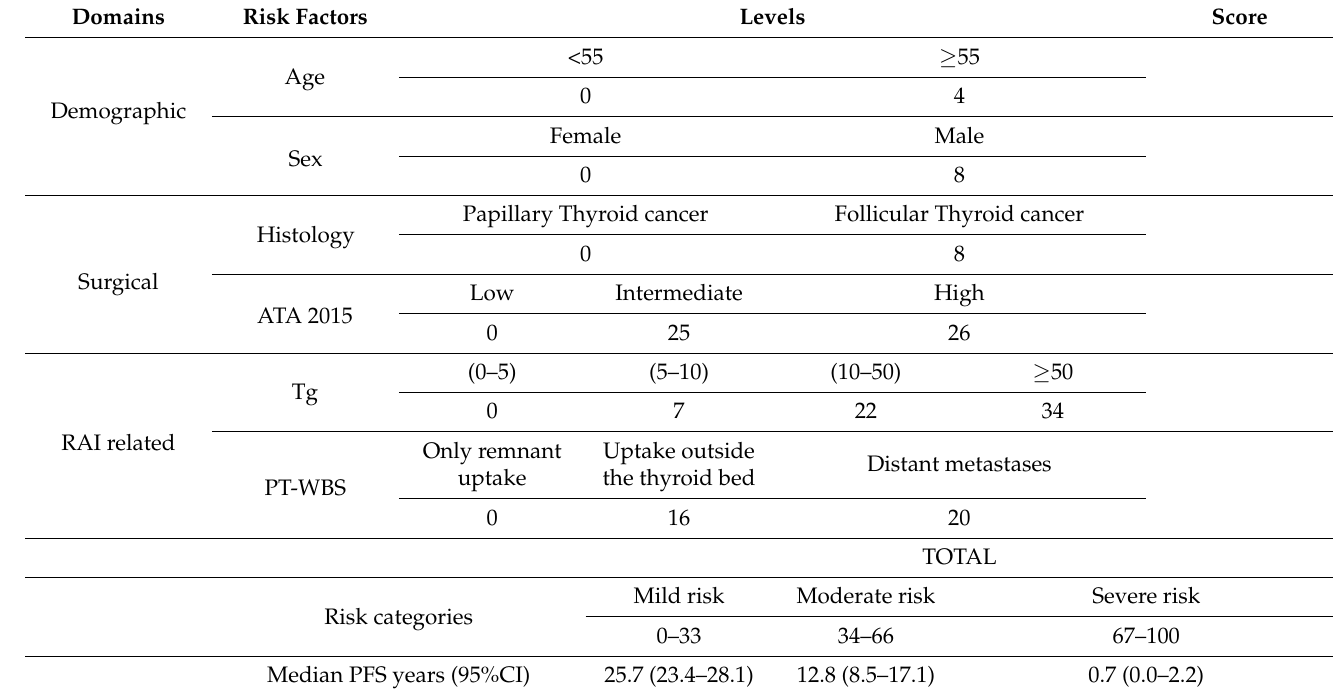
Table 4. Calculation of the three-domain scoring system.